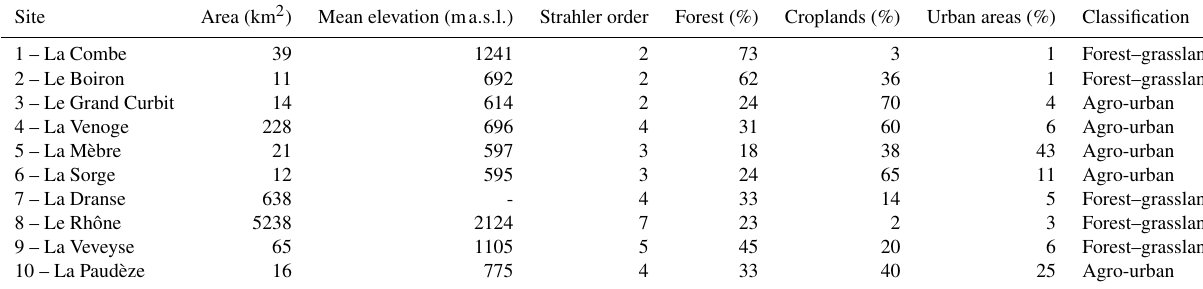
Figure 1. Map of the Lake Geneva basin and the 10 independent catchments sampled during this study. Table 1. Selected properties and dominant classification of sampling sites